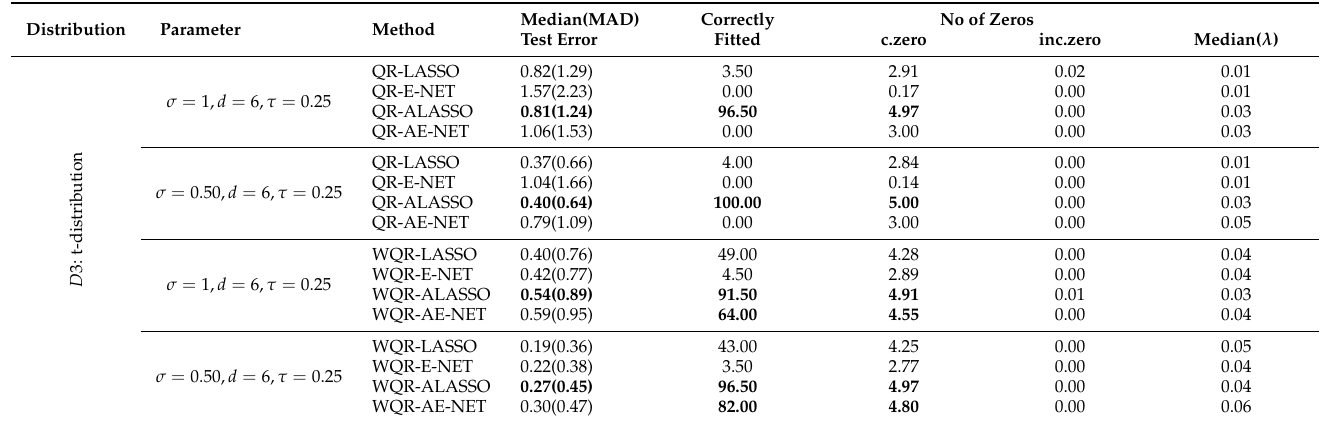
Table A4. Penalized weighted and unweighted quantile regression at D 3 for n = 50 ( τ = 0.25) under the heavy tailed t-distribution.